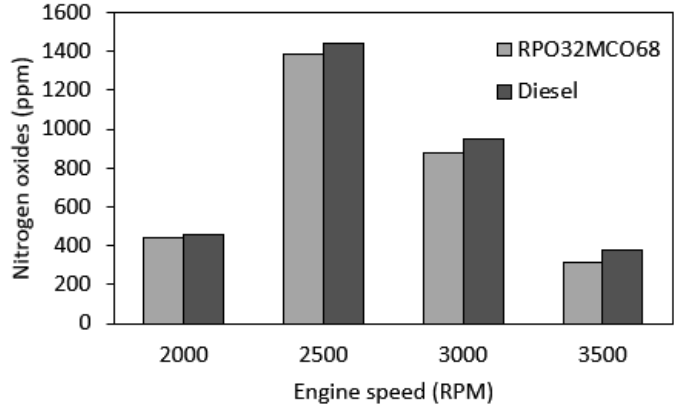
Figure 13. Comparison of nitrogen oxide emission as a function of engine speeds.